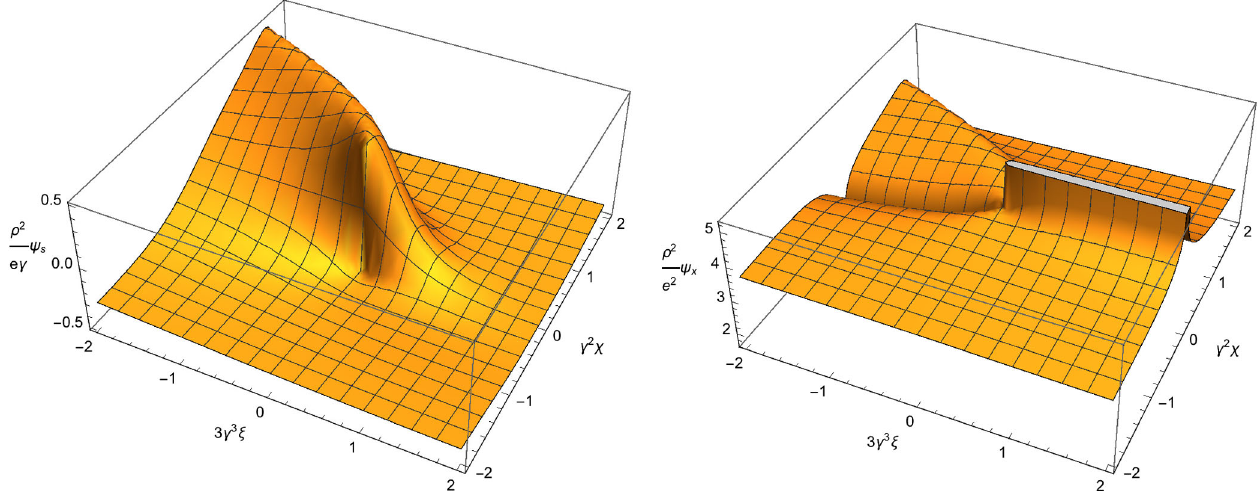
FIG. 3. The scaled longitudinal field E with γ ¼ 500 .